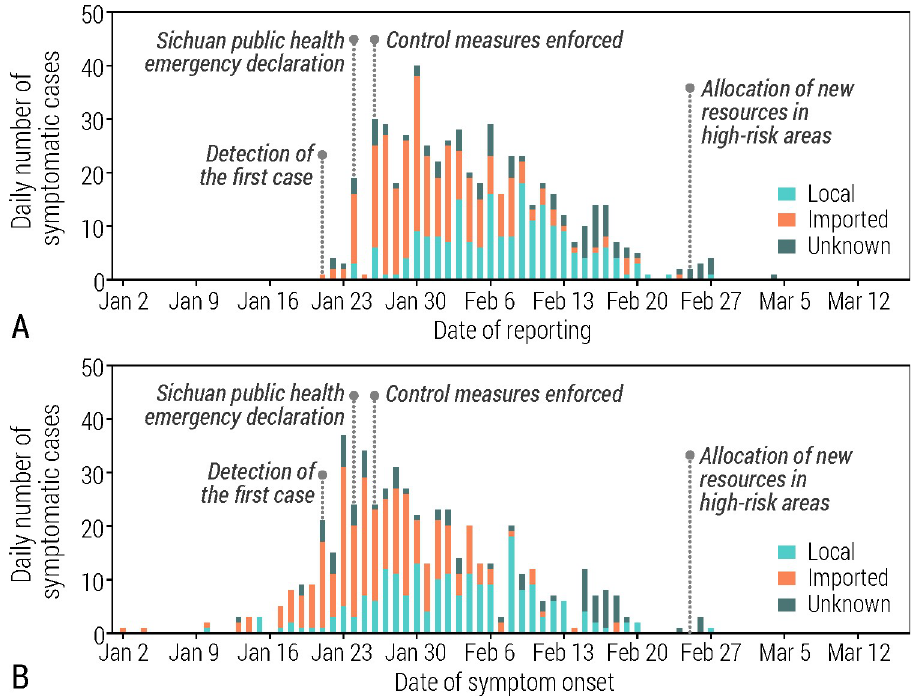
Fig 1. A Daily number of new symptomatic cases in Sichuan by date of reporting, disaggregated into cases with travel history to Wuhan/Hubei (imported), cases resulting from local transmission (local), and those for whom the travel history was unknown (unknown). B Same as A, but by date of symptom